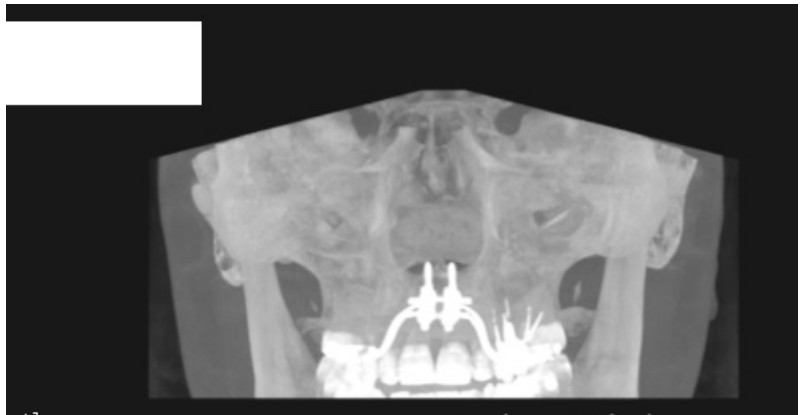
Figure 3. MARPE device in position after cementation.